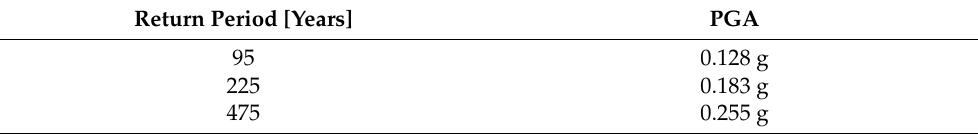
Table 3. Peak ground accelerations for various return periods for the selected